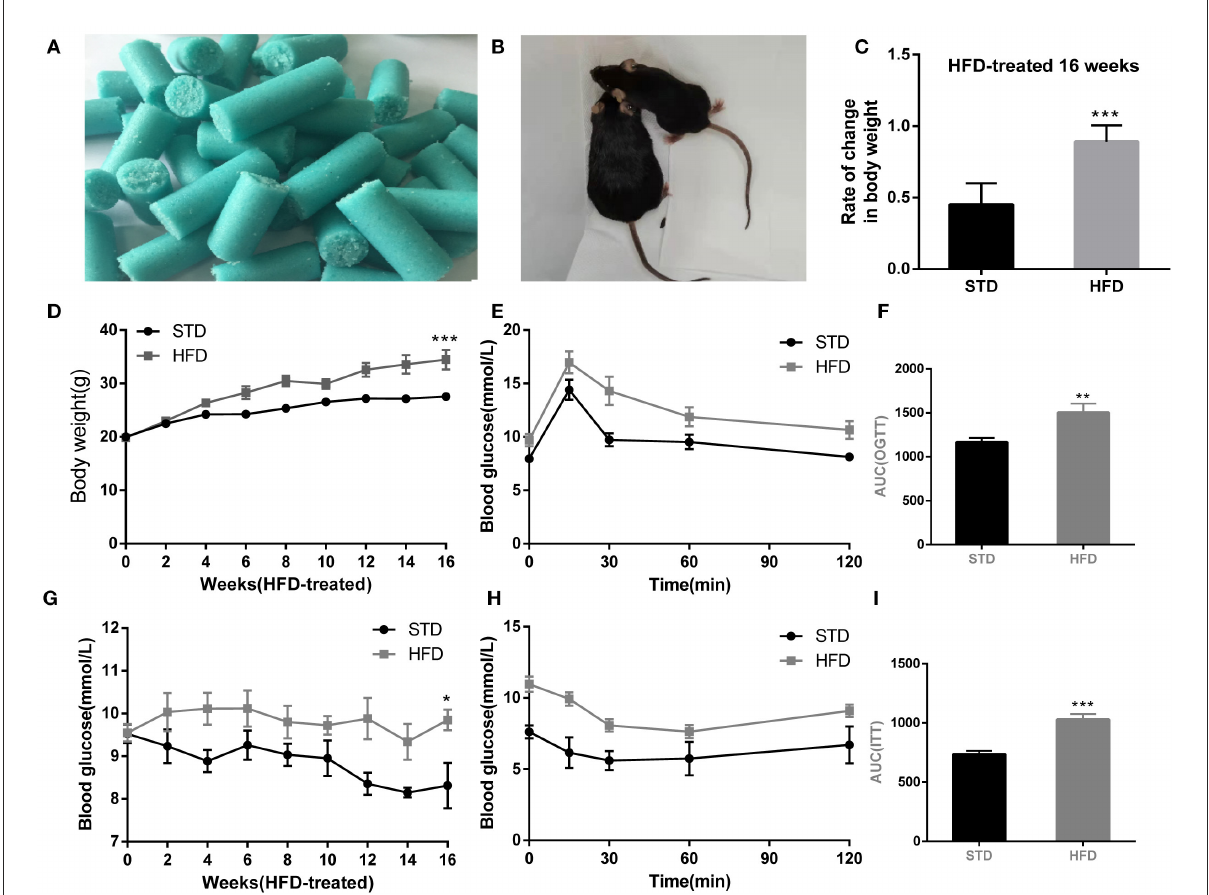
FIGURE1 High-fat diet-induced obesity phenotype in mice. (A) High-fat diet D12492 from Research Diets was used in the study. (B) The picture of the mice treated by STD diet or HFD diet at 16 weeks. (C) Rate of change in body weight of the mice with HFD fed at 16 weeks. (D) The body weight of the mice during the HFD treatment was observed. (E) Levels of blood glucose during OGTT test. (F) Area under the curve from OGTT test. (G) Levels of random blood glucose of mice during feeding high-fat diet. (H) Levels of blood glucose during ITT test. (I) Area under the curve